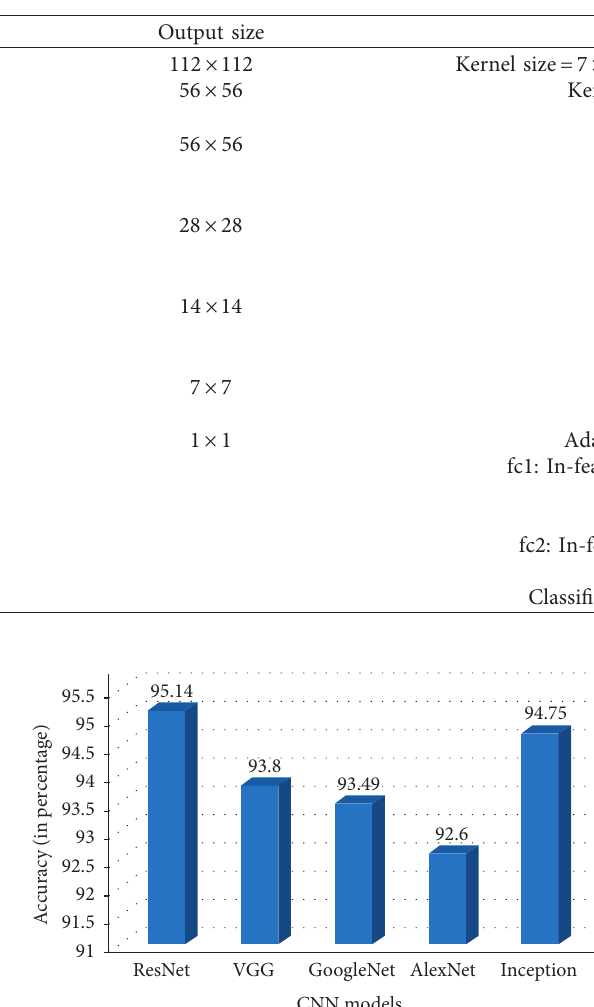
Table 1: Architecture of modified CNN.